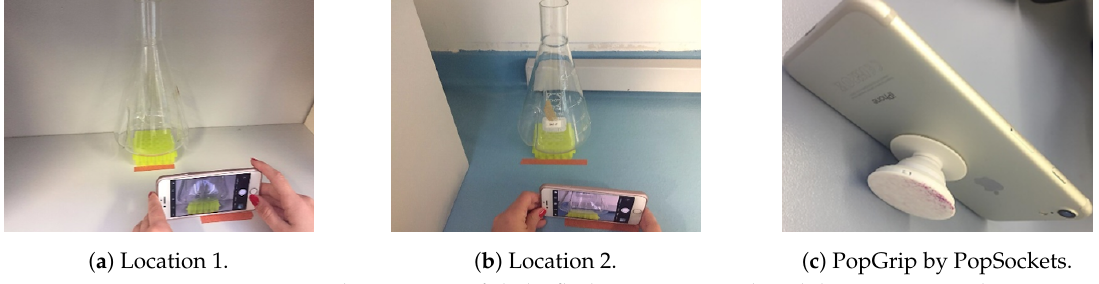
Figure 2. Locations, where images of shake flasks were acquired, and the PopGrip used.